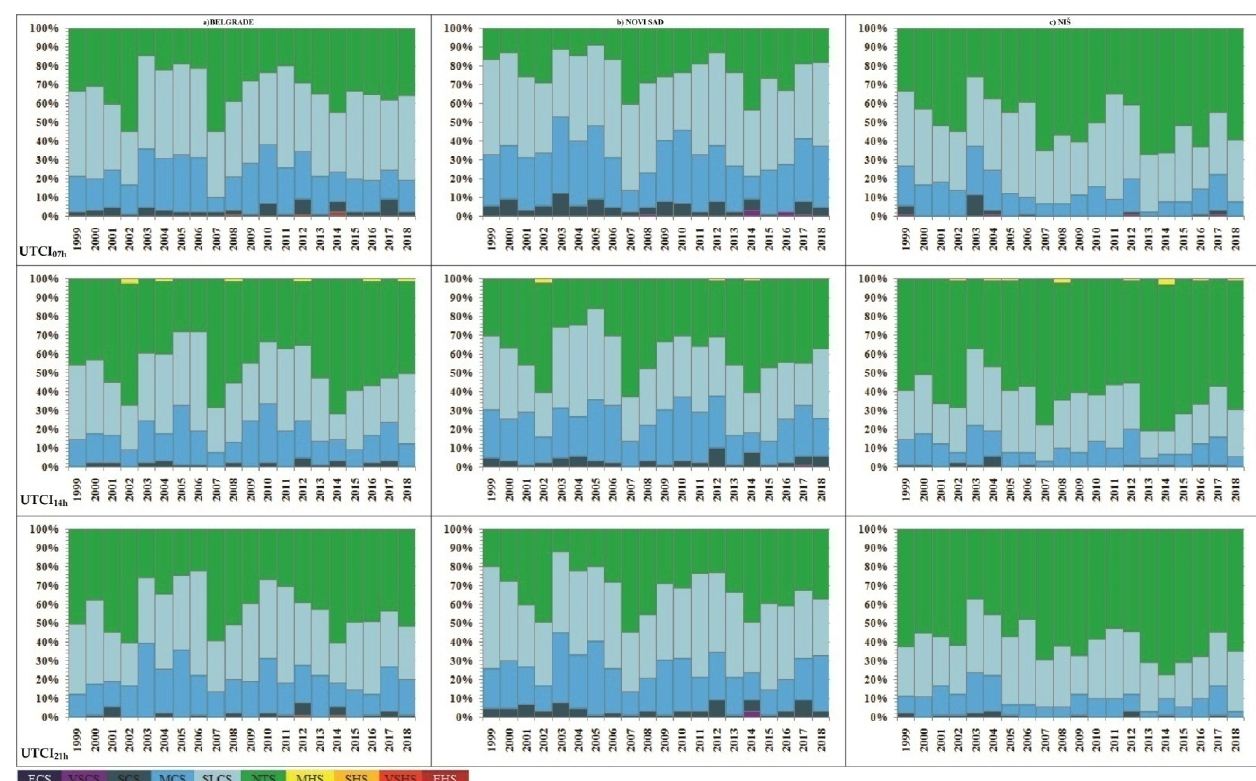
Figure 5. Frequencies of different cold and heat stress category in ( a ) Belgrade; ( b ) Novi Sad; and ( c ) Niš based on UTCI 07h (first column), UTCI 14h (second column), UTCI 21h (third column) during winter, over a period of 20 years (1999–2018).